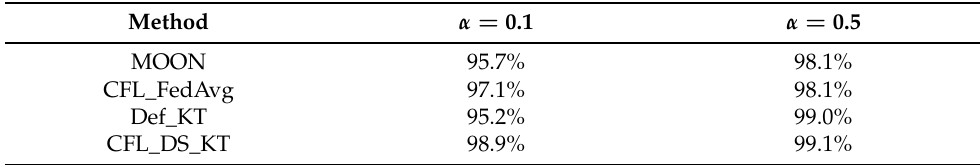
Figure 12. A performance comparison of the different methods when α = 0.5. Table 2. The top-1 test accuracy with α = 0.5 and α = 0.1 on MNIST